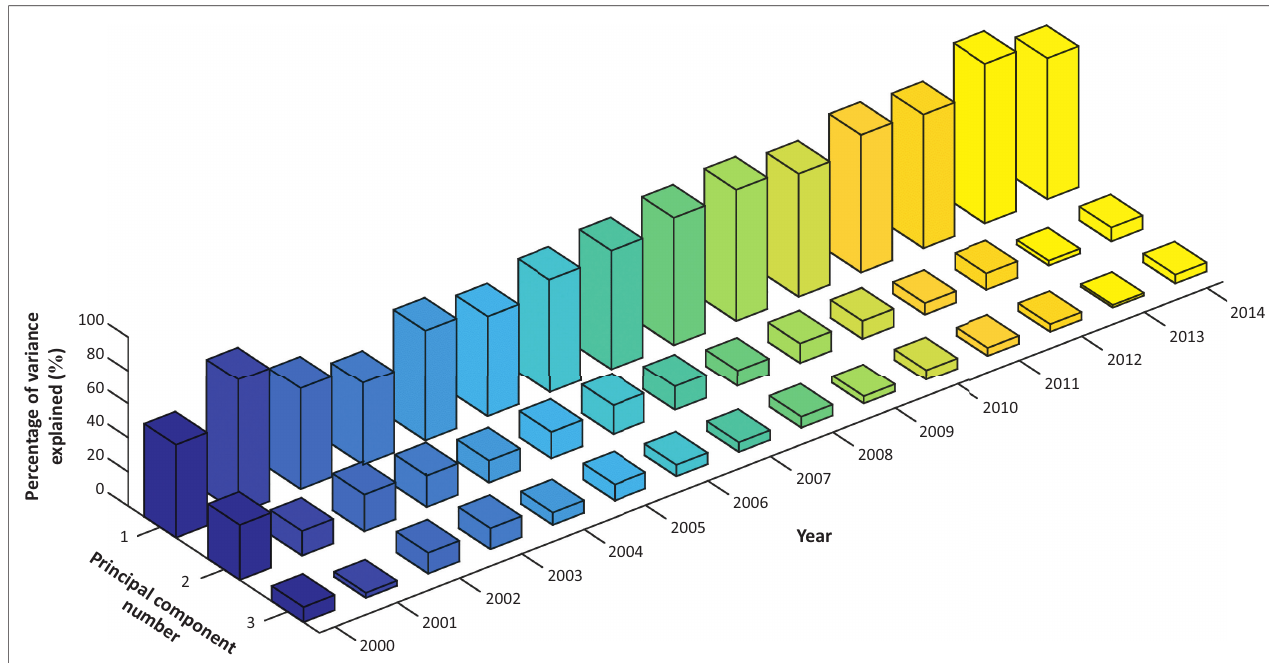
FIGURE 14: Variations in percentage of variance explained for each South African principle component: 2000–2014.